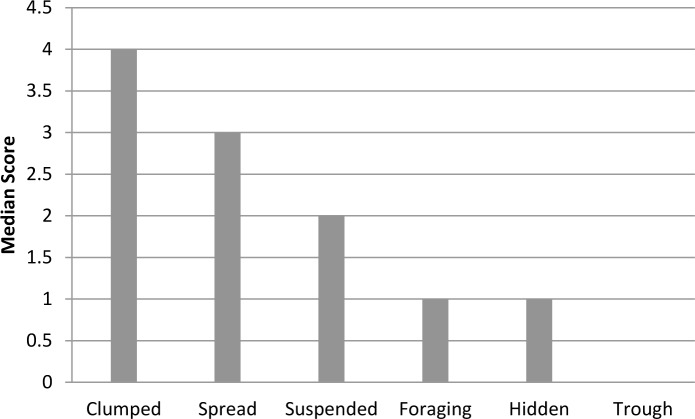
Median scores for feed presentation methods from 64 zoos.Each categorical scale score represents use ranges in 10% increments (e.g., 1 = 1–9%, 2 = 10–19%). Scores of 0 represent no use and scores of 11 represent use 100% of the time. Categories included clumped [food placed in piles composed of multiple flakes of hay, browse items, or pellet], spread [food distributed through the exhibit], suspended [food suspended by rope, in a bag, open sided barrel, etc.], foraging [food provisioned in a feeding apparatus], hidden [food hidden around the exhibit], trough [food place in an open trough].